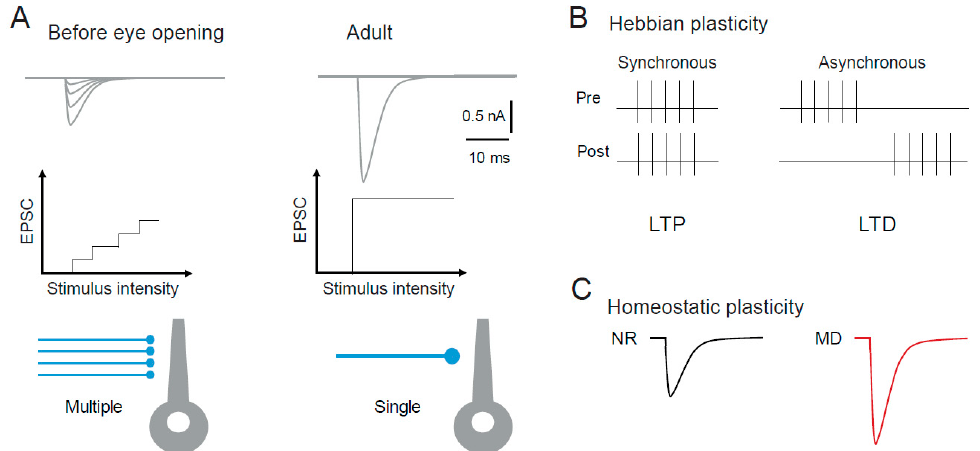
Figure 3. Plasticity in the dLGN. ( A ) Structural plasticity. Refinement, synapse elimination and synapse strengthening at rodent retino-geniculate inputs during postnatal development. Synaptic currents evoked by increasing stimulus intensity before eye opening (left) and in the adult (right). Note the multiple and small synaptic responses in immature dLGN neurons and the all-or-none and large response in mature dLGN neurons. ( B ) Hebbian synaptic plasticity at retino-geniculate synapses induced by pairing presynaptic stimulation with postsynaptic firing with synchronous (left) or asynchronous (right) relation. Adapted from [62]. ( C ) Homeostatic plasticity at cortico-geniculate synapses. MD induces an up-regulation of synaptic transmission. Adapted from [63]. NR, normal rearing.